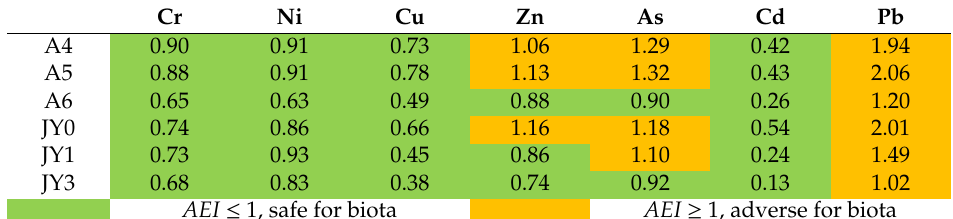
Table 3. Biological adverse e ff ect index ( AEI ) based on e ff ect range-low ( ERL ) values for di ff erent MMEs at di ff erent sampling sites in JRE.